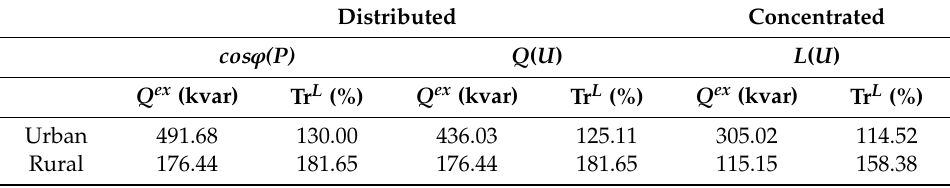
Table 2. Reactive power consumption, loss, and exchange for different control strategies in real LVGs.